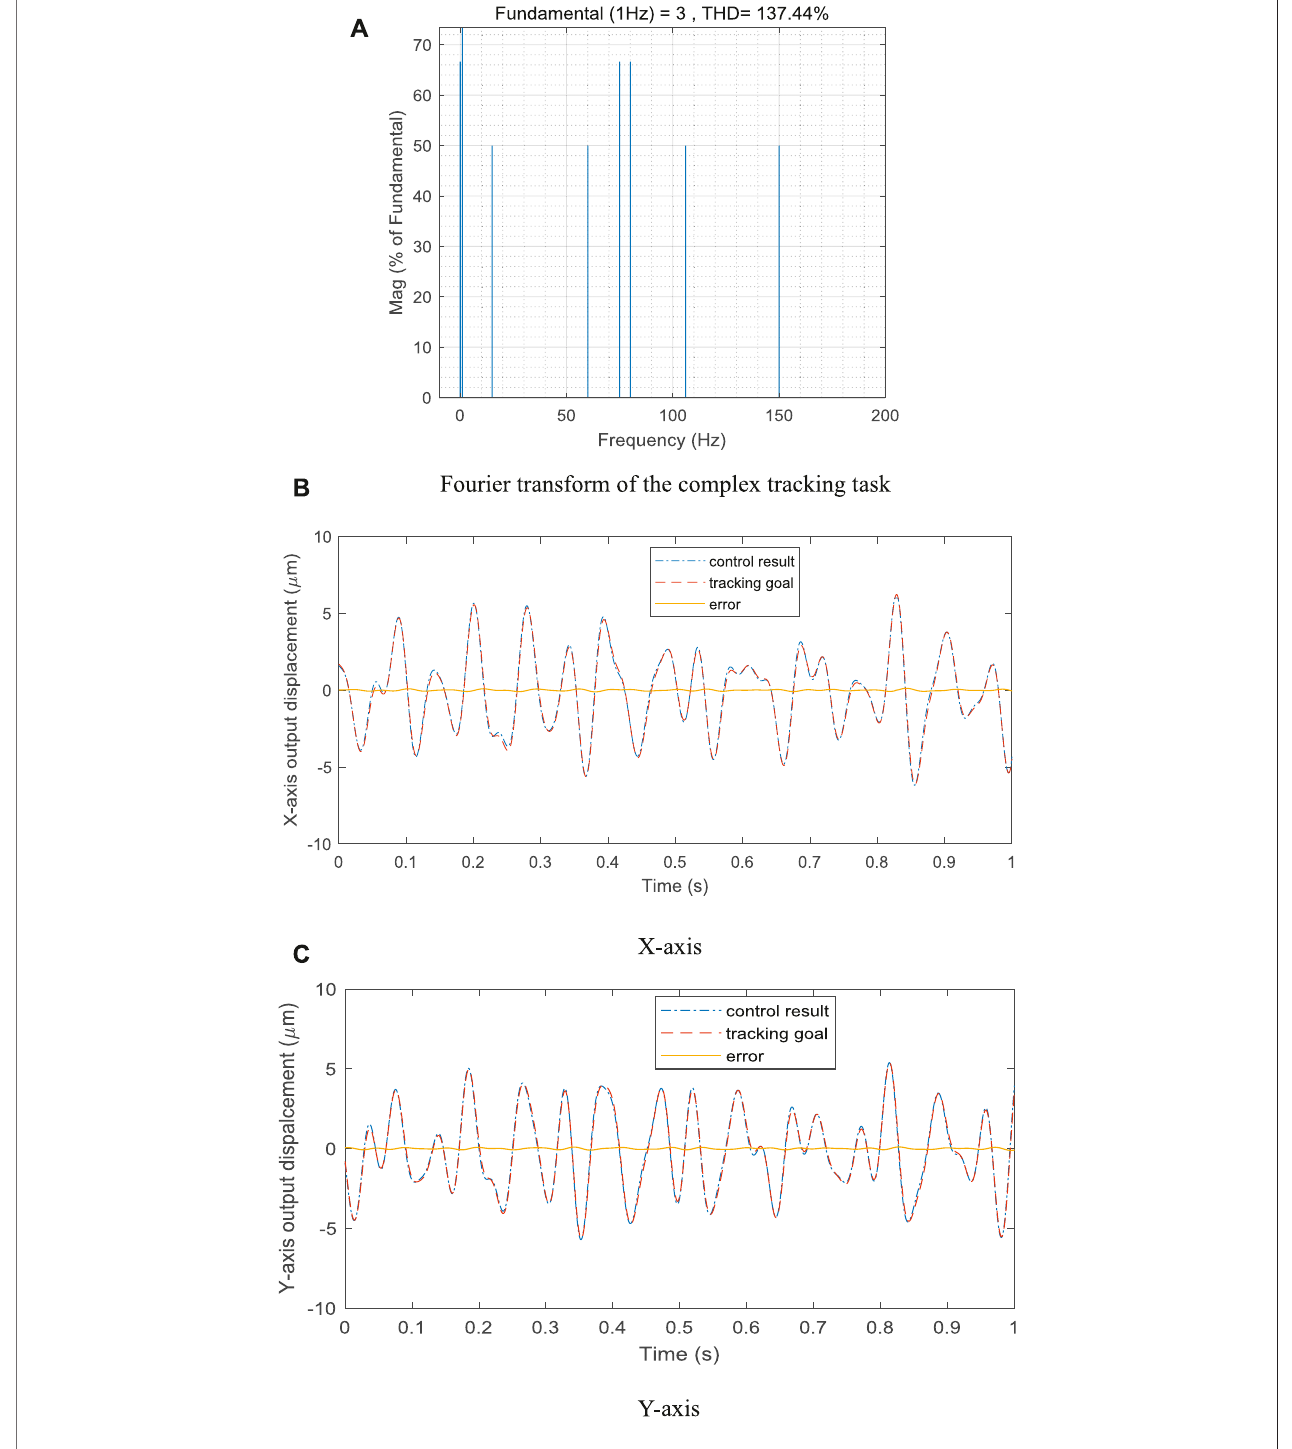
Frontiers in Materials |